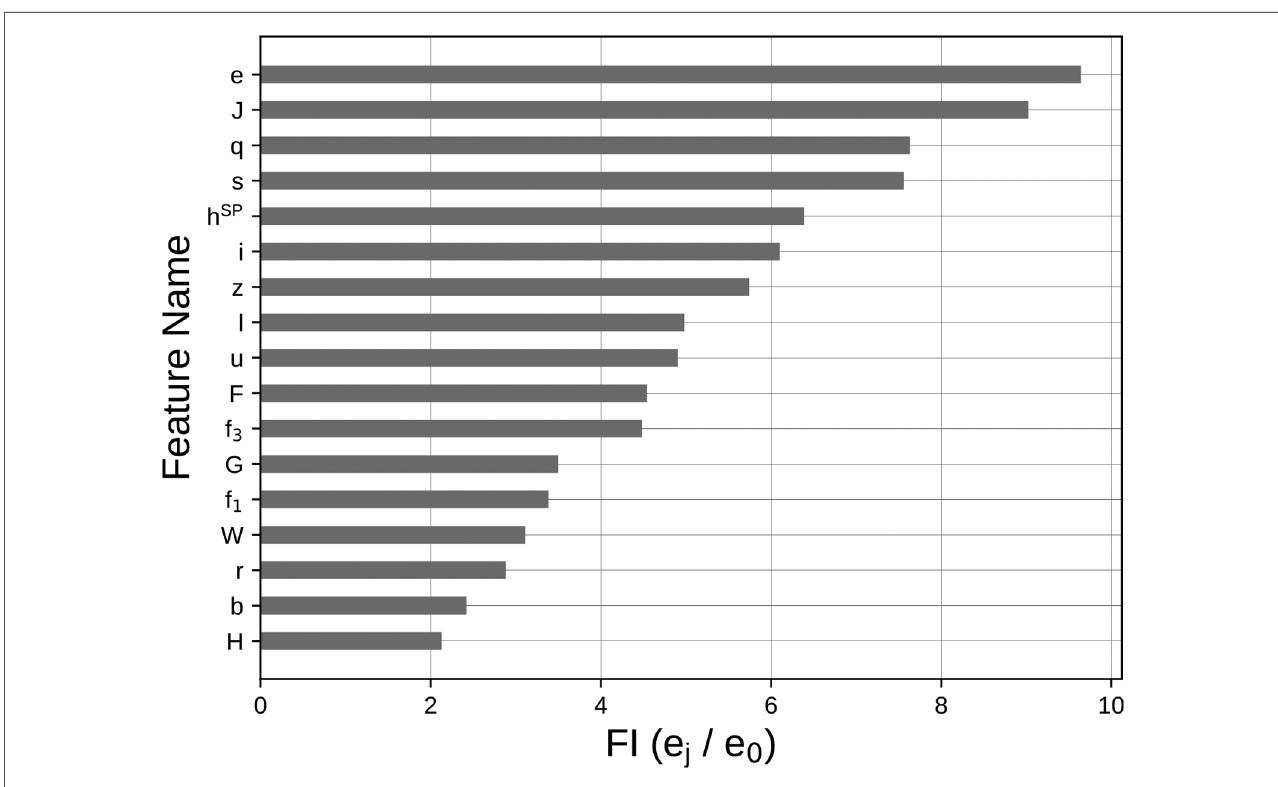
FIGURE 6 Barchart representing the outcome of the PFI analysis performed on all the variables selected by the Lasso regularization. Variables meaning is detailed in Table 1 .